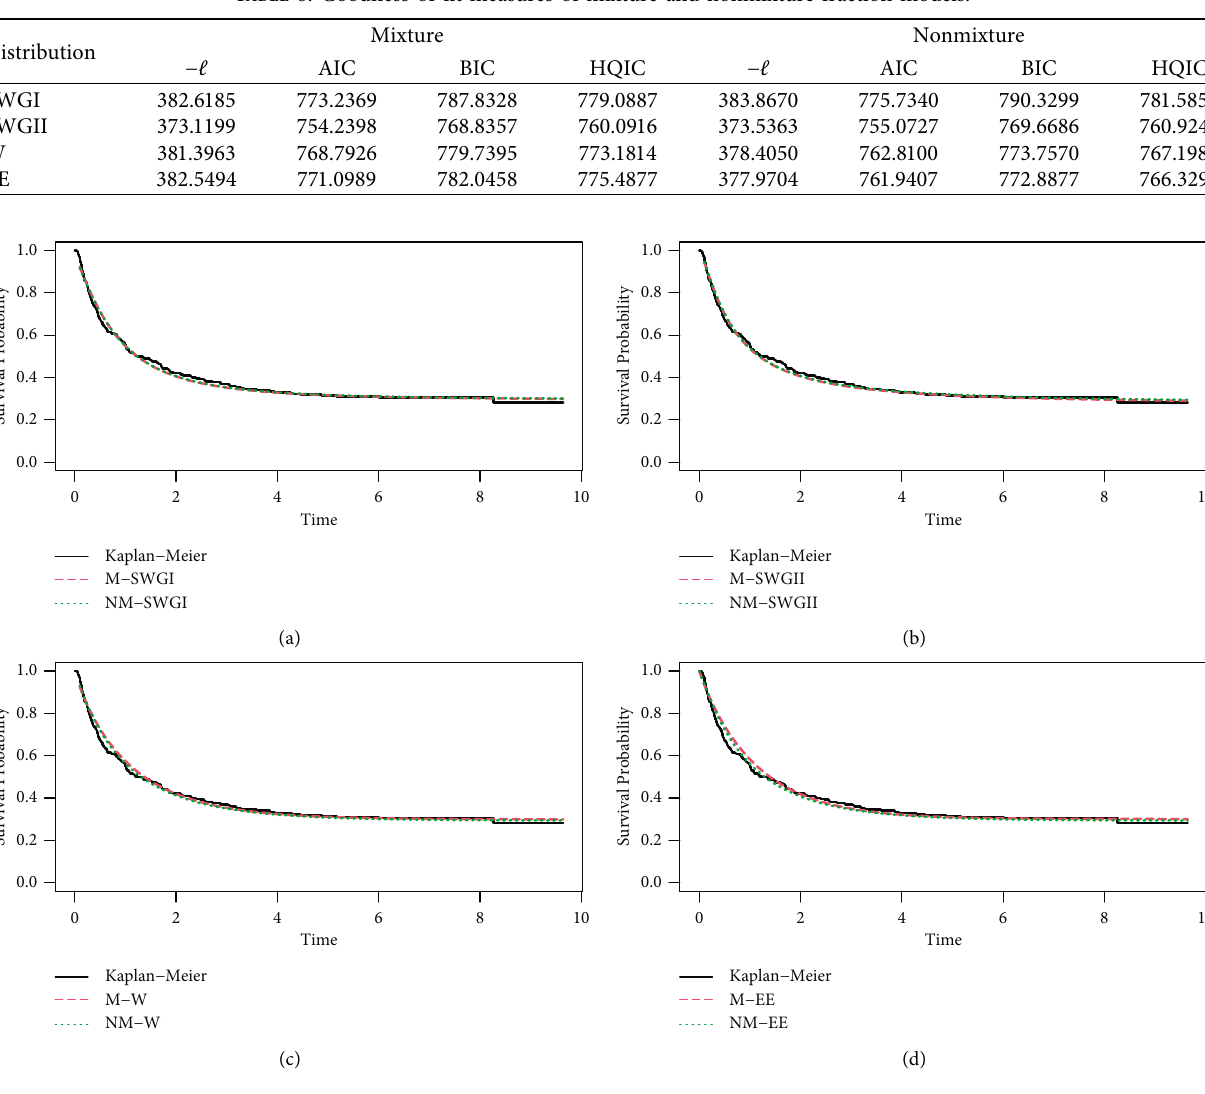
Table 8: Goodness-of-fit measures of mixture and nonmixture fraction models.